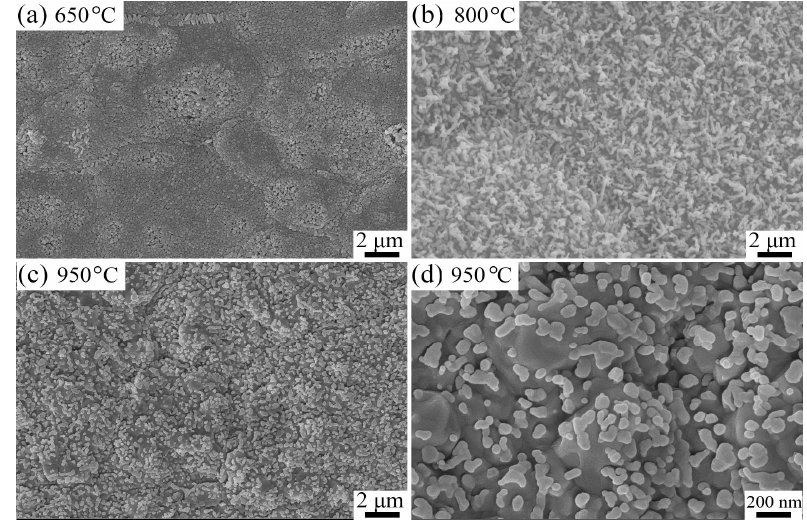
Figure 3. SEM micrographs of LSCF sample after the treatment of depositing nickel at different temperatures for 1–h: ( a ) 650 °C; ( b ) 800 °C; ( c ) 950 °C; and ( d ) magnified picture of ( c ). temperatures for 1-h: ( a ) 650 ◦ C; ( b ) 800 ◦ C; ( c ) 950 ◦ C; and ( d ) magnified picture of ( c